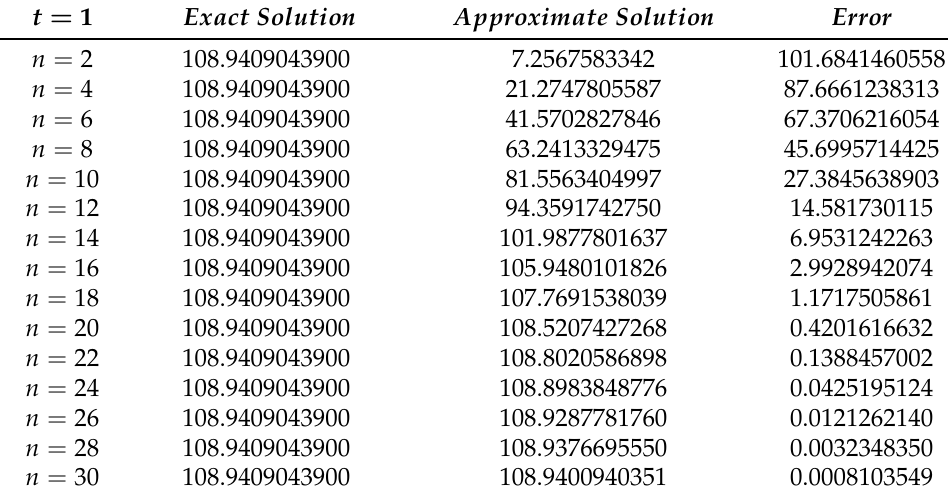
Table 3. Error estimates at x = y = 0, t = 1 for α =